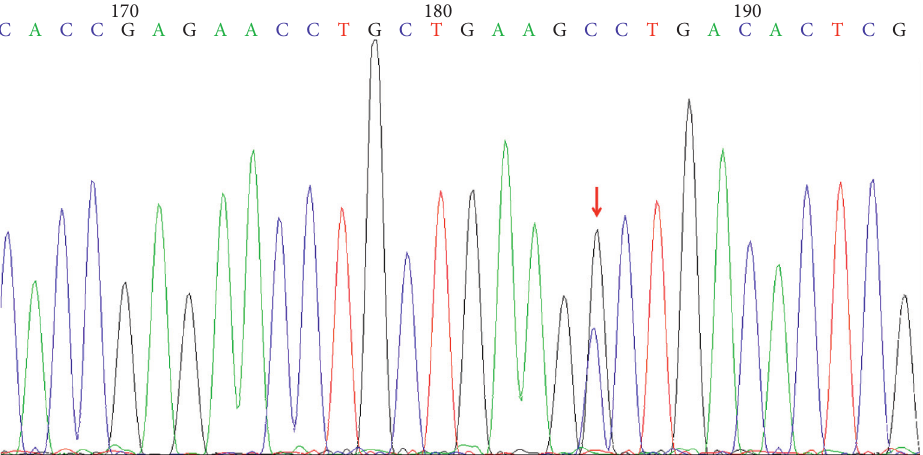
Figure 7: Sanger validation results of ITGB4 variant in the patient with UC associated with PSC and SSA. Arrow represents the mutation